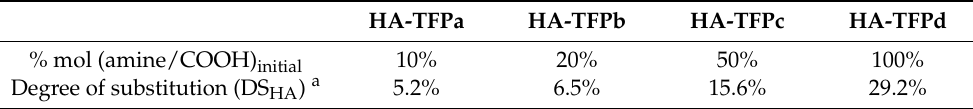
Table 3. Degrees of substitution of HA functionalized with trifluoropropyl-amine. HA-TFPa